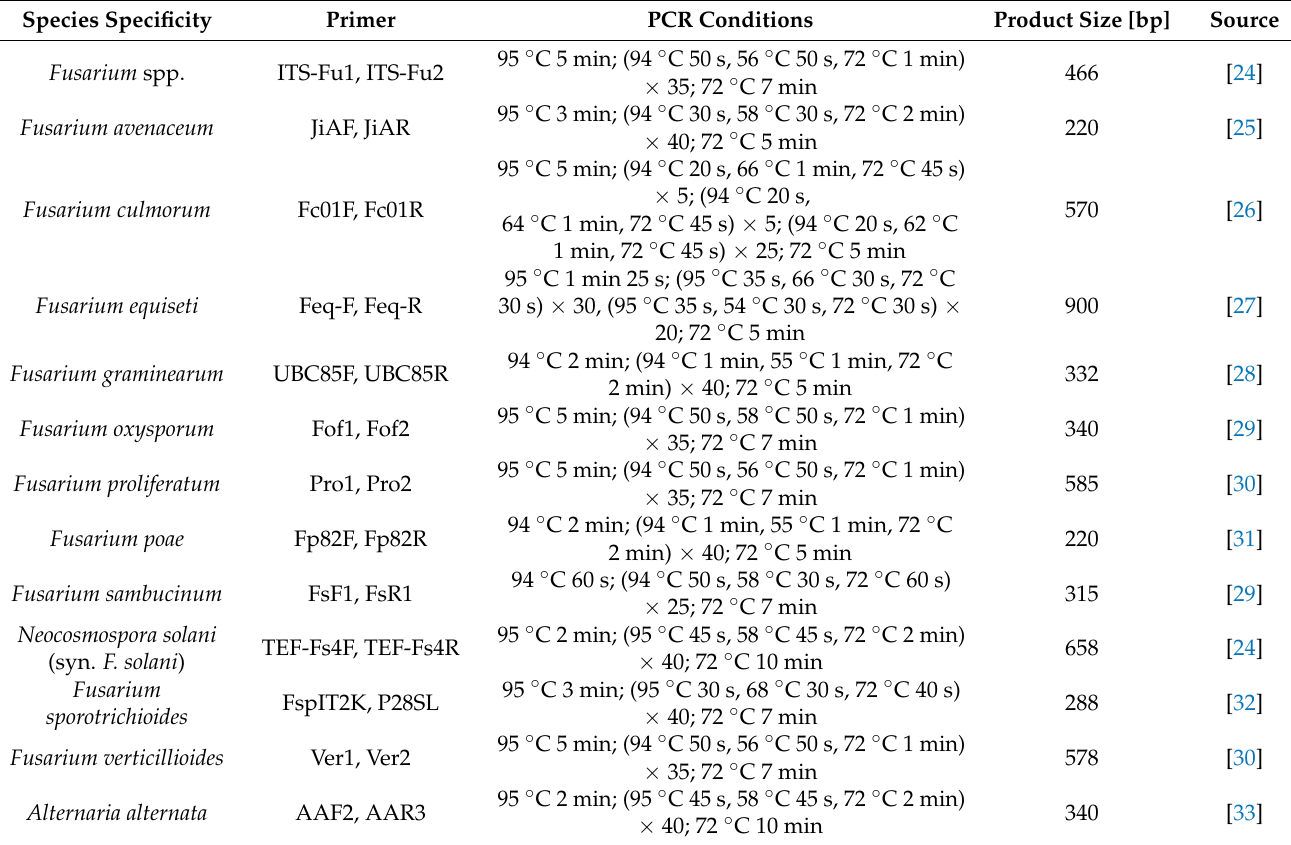
Table 2. Primers used and PCR conditions for determining fungus